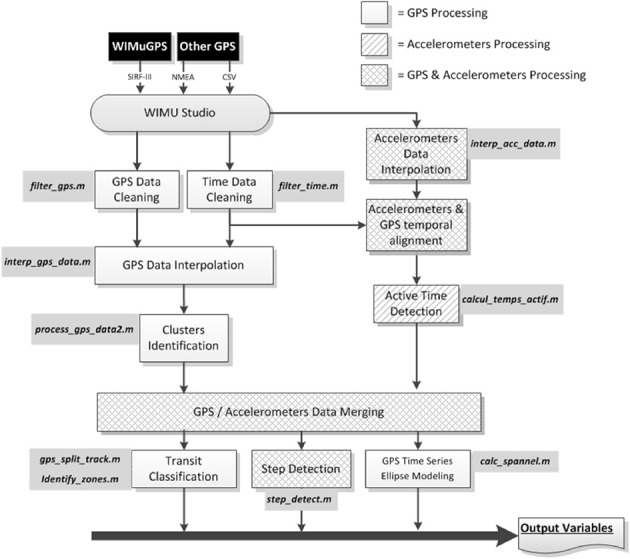
Analysis workflow.